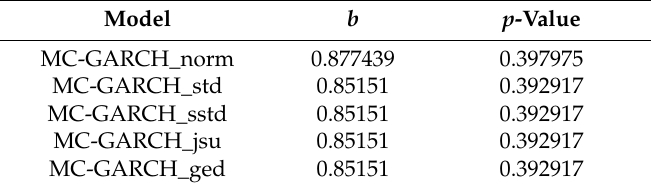
Table 6. Intraday VaR forecast: duration-based approach VaR backtesting results.